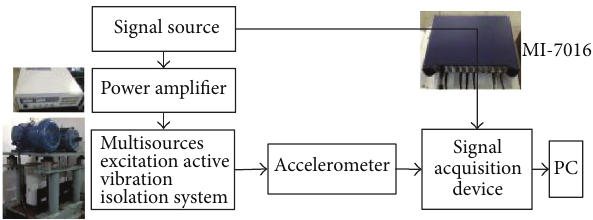
Figure 2: Data acquisition system of model identification experi- ment.